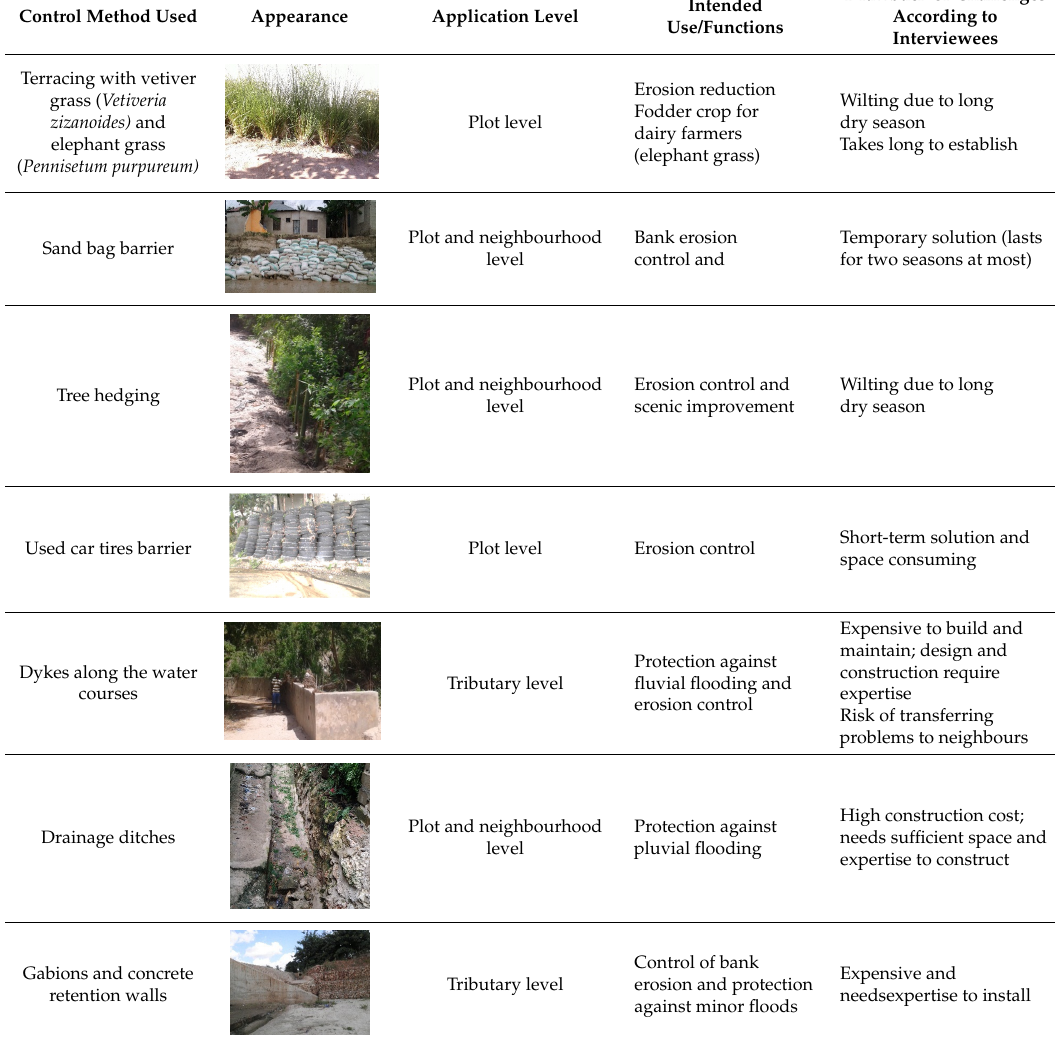
Table 2. Overview of stormwater management measures implemented by residents in the Mbezi River catchment, and their drawbacks according to questionnaire survey. The most commonly used measures are listed first.